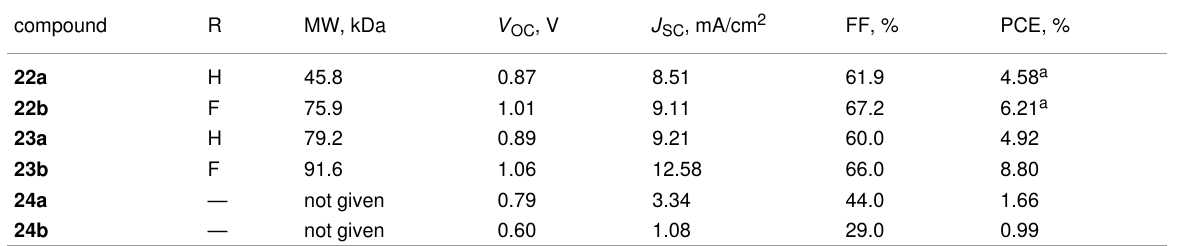
Table 4: Molecular weight and photovoltaic properties of OSCs based on polymers 22 – 24 . compound